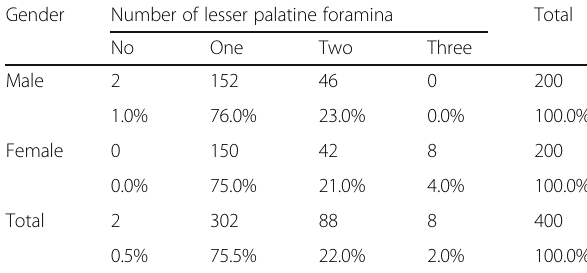
Table 4 Number, frequency, and percent of lesser palatine foramina based on